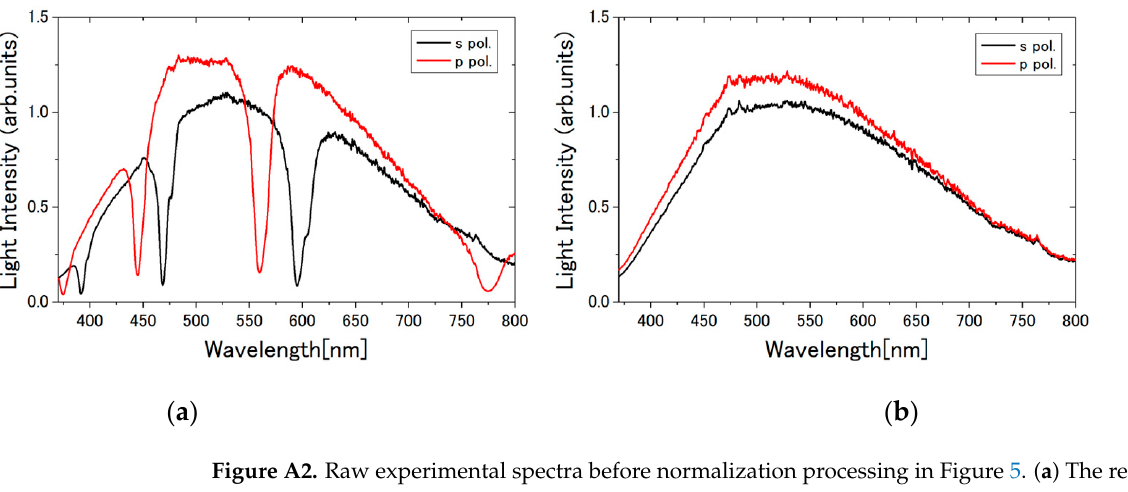
Figure A2. Raw experimental spectra before normalization processing in Figure 5. ( a ) The reflected light intensity spectra (p- and s-polarized) of the transparent PVP film on the transparent MgF 2 substrate at θ air = 88.5 ◦ incidence in air. ( b ) The baseline transmitted light spectra (p- and s-polarized) at 90 ◦ incidence ( = normal incidence from the side, thus transmitted through the substrate without being reflected by the PVP film) used as the denominator for normalization.